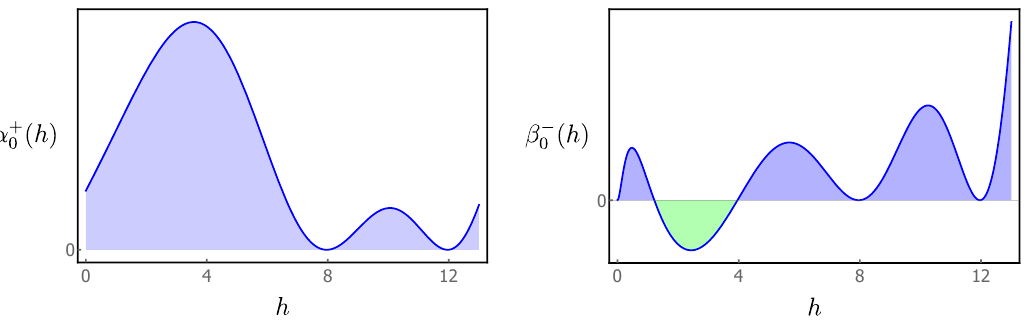
( h ) and (cid:12) (cid:0) ( h ) for (cid:1) (cid:30) = 1. Since we only 0 0